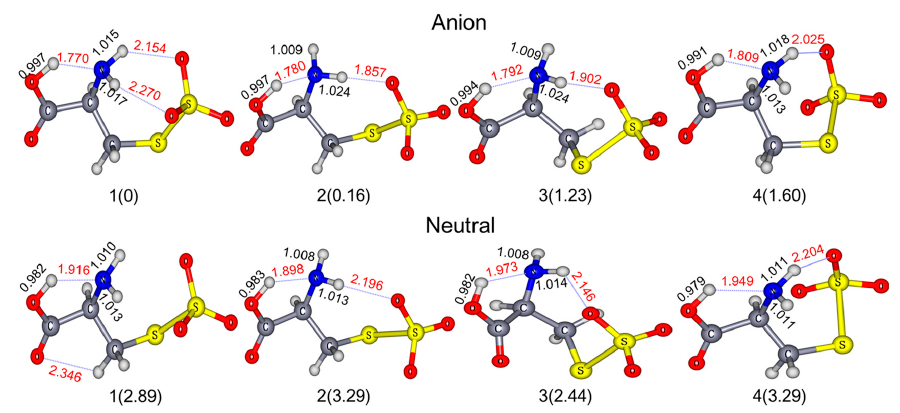
Figure 2. The top four lowest-lying energy conformers of cysteine perthiosulfonate anion [cysS-SO 3 ] − along with its corresponding neutral counterparts.